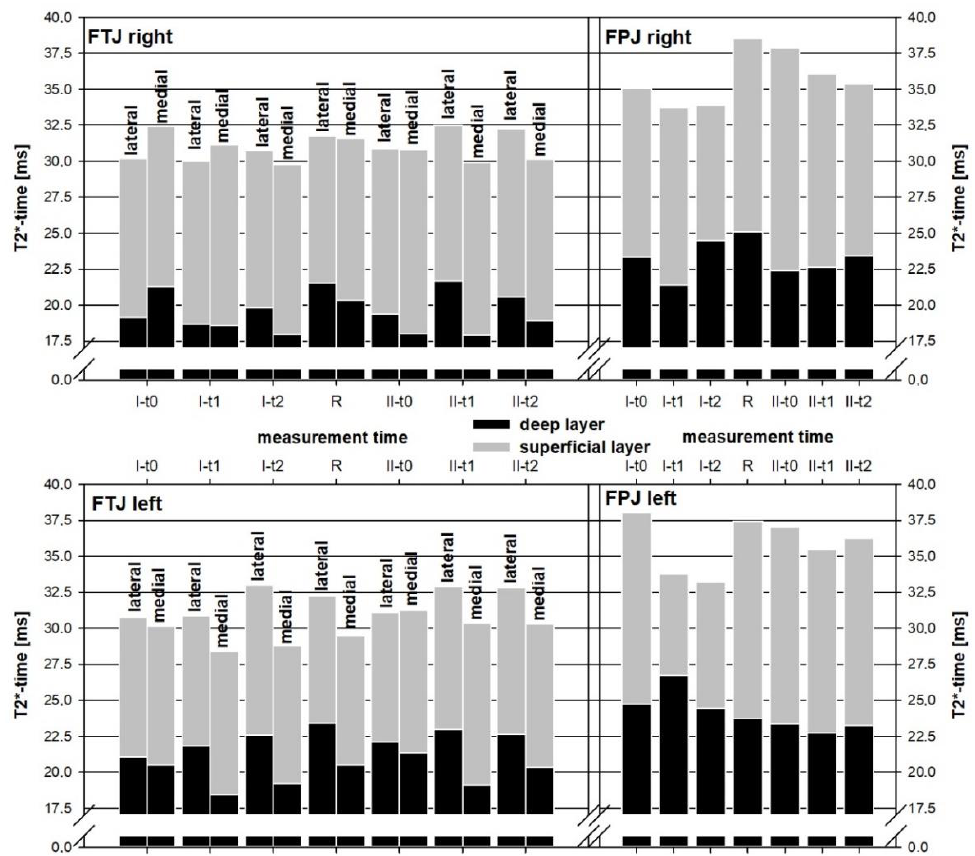
Figure 5. Absolute Changes of Layer-Related Mean Cartilage T2*.